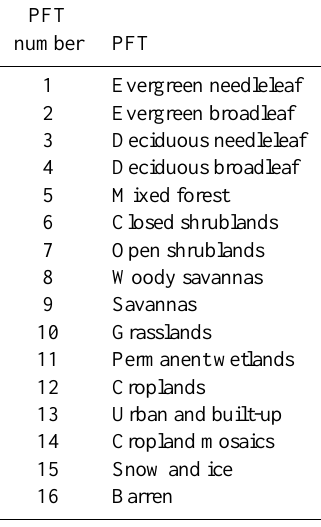
Table 2. Names of plant functional types (PFTs) and soil types shown in Fig.